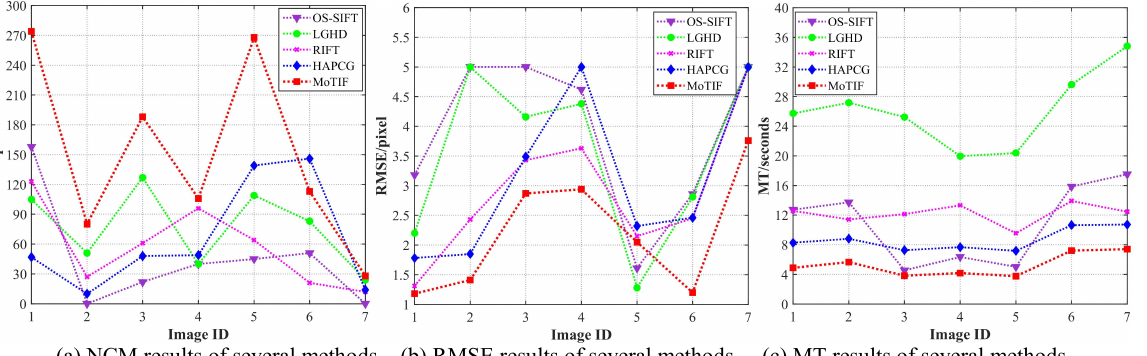
Figure 4 . Quantitative results of several methods.